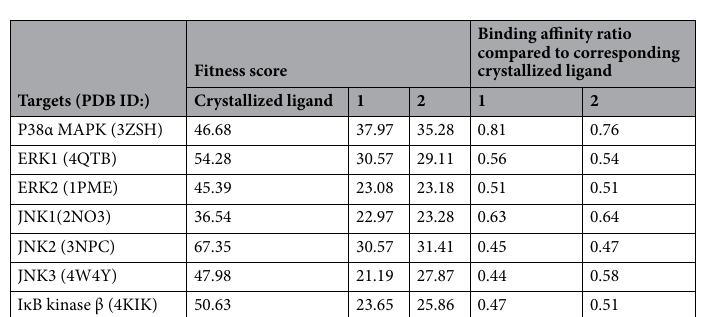
Figure 5. Focused ligand binding sites and ligand intermolecular interactions with surrounding amino acids of ( A ) p38-α MAPK at the ATP-binding site and ( B ) the TLR4-MD2 interface in complex with docked conformations of 1 , 2 , and reference compounds (SB203580 for P38-α MAPK at the ATP-binding site and ZINC25778142 for TLR-4); pink, green, and light blue denote hydrophobic, conventional hydrogen bond, and halogen interactions, respectively. This molecular recognition analysis was based on the rigid docked conformation predictions.